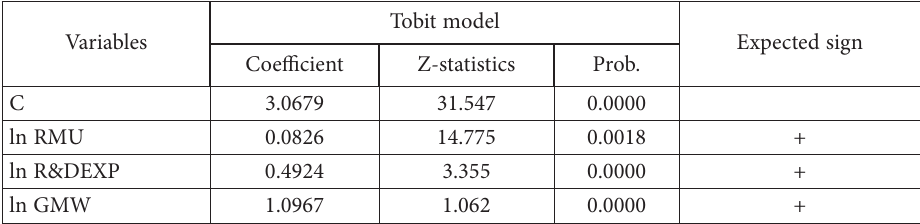
Table 10. Determinants of GDP per capita – summary of the Tobit model Variables